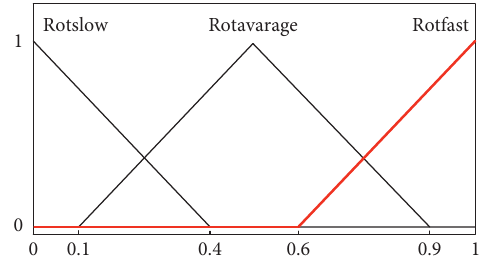
Figure 19: FV membership functions for LV ω